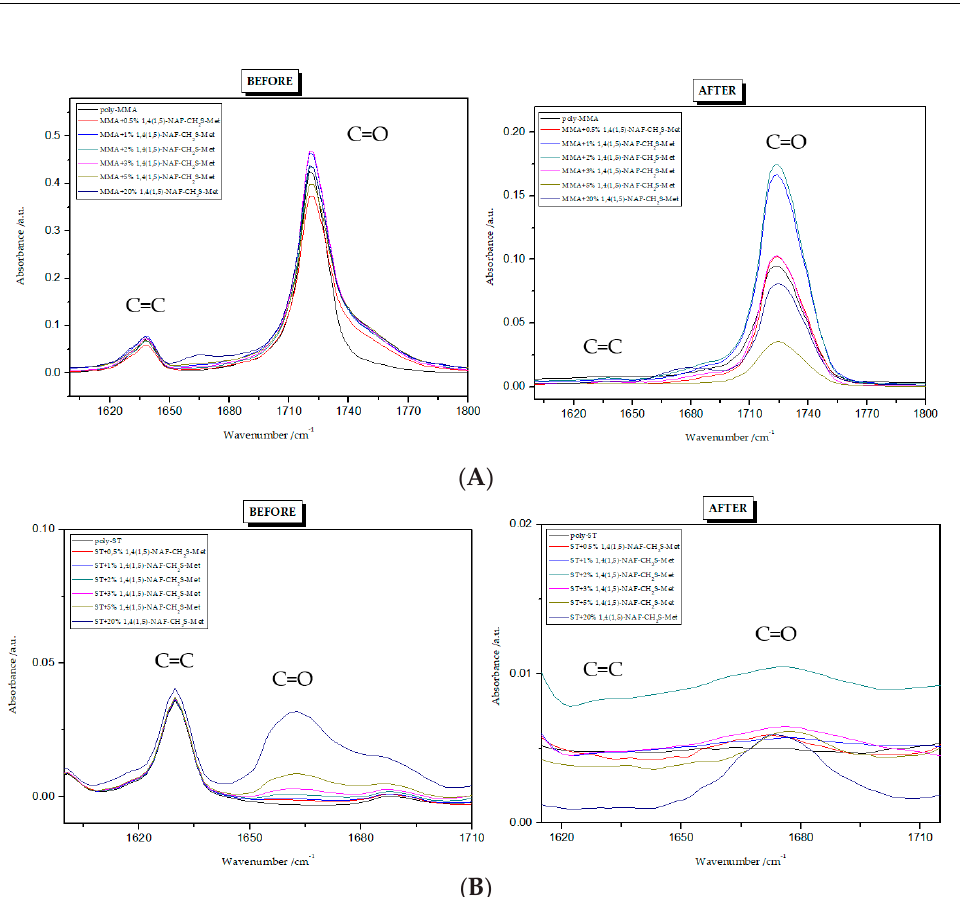
Figure 6. FTIR spectra of 1,4(1,5)-NAF-CH 2 S-Met polymers: ( A ) copolymers with MMA; ( B ) copolymers with ST.